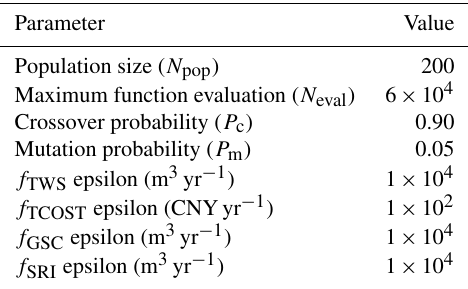
Table 1. The control parameters of the ε -MOMA and epsilon value of